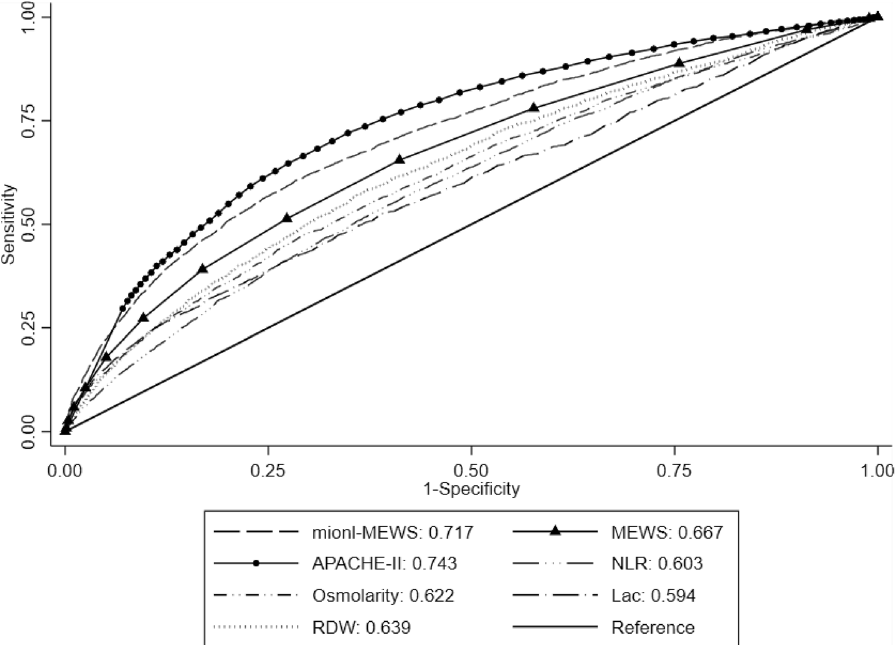
Figure 4. Predictive performance of the mionl-MEWS, APACHE-II, MEWS, neutrophil-to-lymphocyte ratio (NLR), red cell distribution width (RDW), lactate (lac) concentration, and osmolarity level for 28-day mortality in critically ill patients in the development cohort.